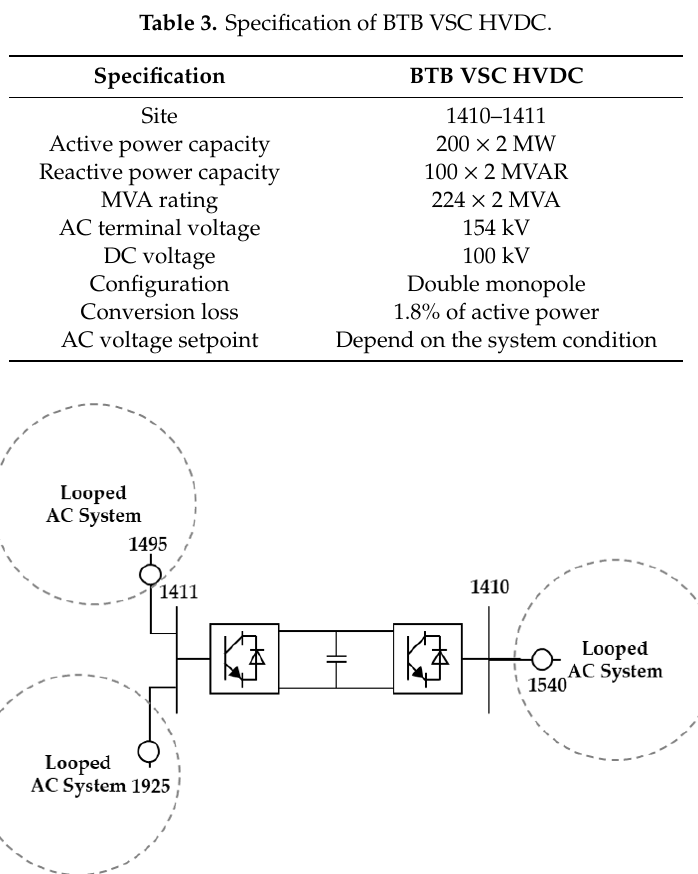
Figure 6. BTB siting in the Korean metropolitan area (1411 – 1410). Table 2. System information.